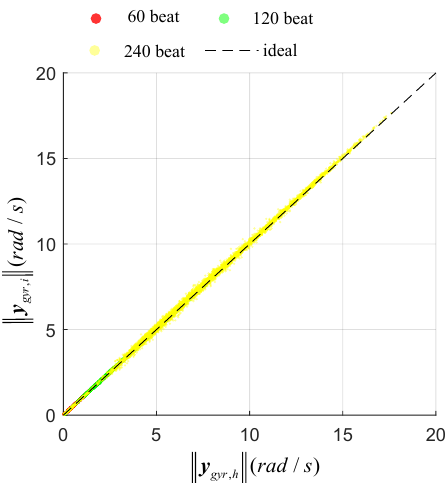
Figure 5. Relation of output norms between gyroscopes on the dorsal side of the hand and finger tip with different repetition rates.